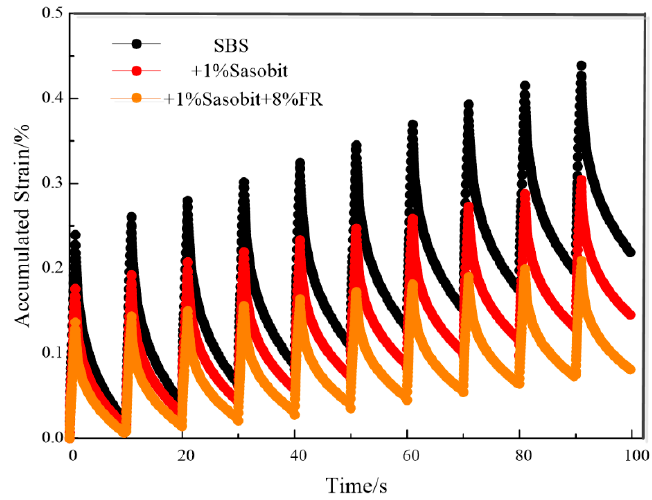
Figure 5. Loading pattern of repeated creep recovery test.